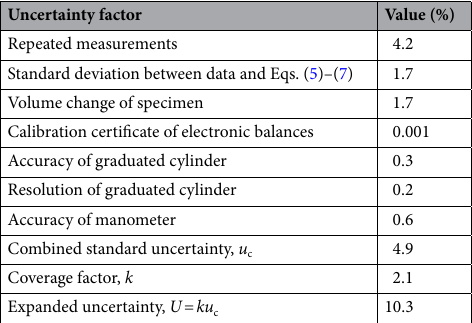
Table 3. Summary of uncertainty factor and relative expanded uncertainty for solubility and diffusivity of gas.